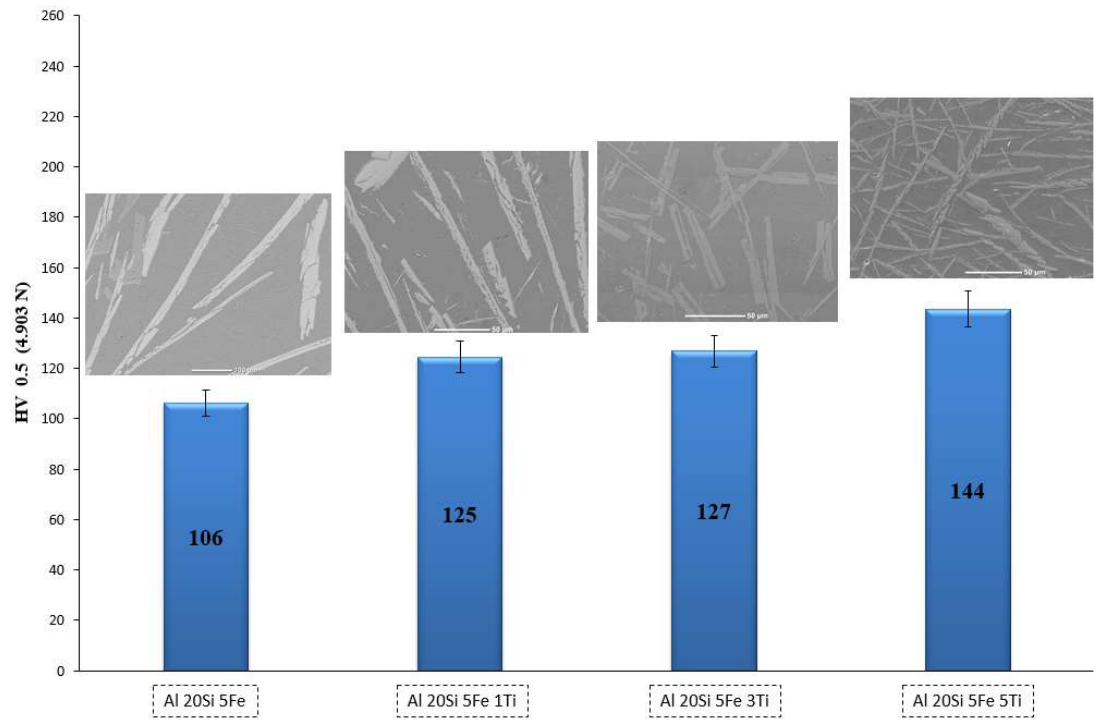
Figure 11. Microhardness of the Al–20Si–5Fe alloy with several Ti additions.